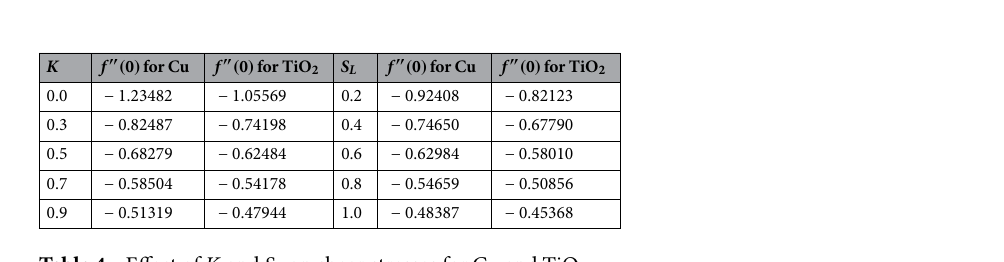
Table 4. Effect of K and S L on shear stresses for Cu and TiO 2